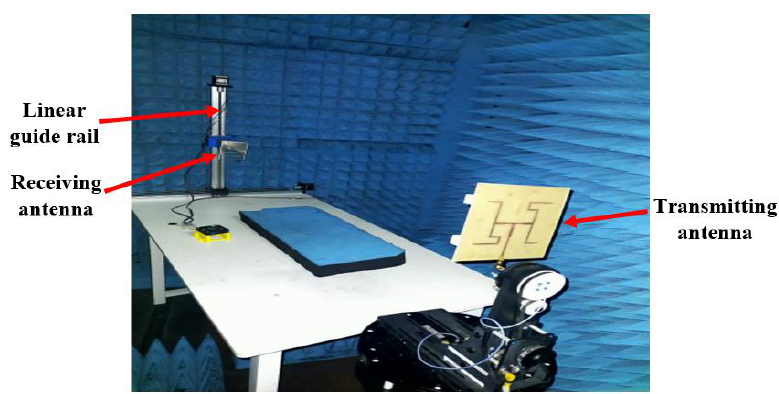
Figure 6. Measurement setup of phase and intensity distributions.